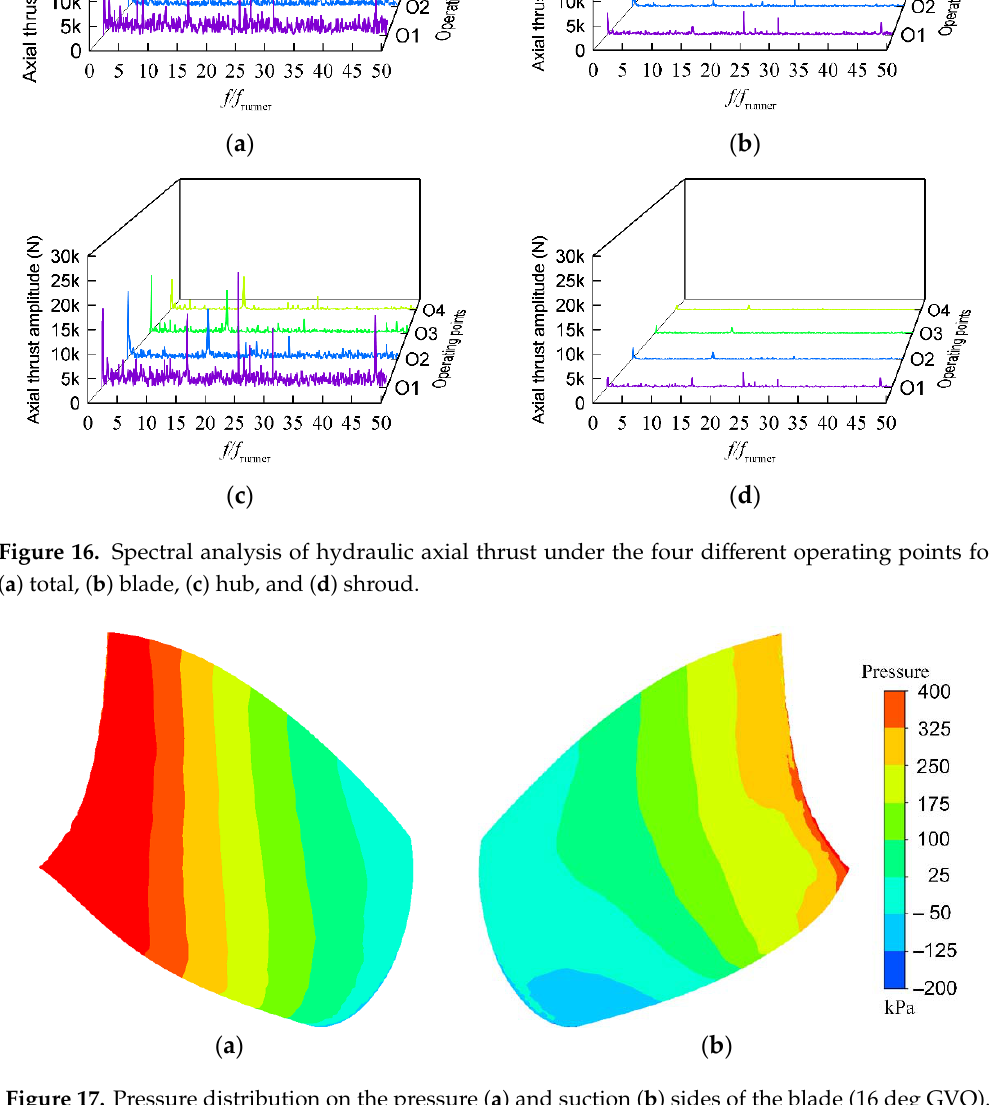
Figure 17. Pressure distribution on the pressure ( a ) and suction ( b ) sides of the blade (16 deg GVO ) . Energies 2020 , 13 , x FOR PEER REVIEW